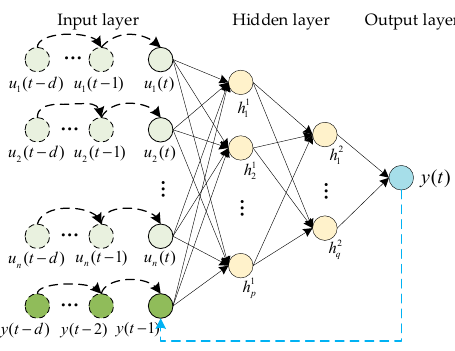
Figure 3. The network for the time series prediction based on the NARX structure.